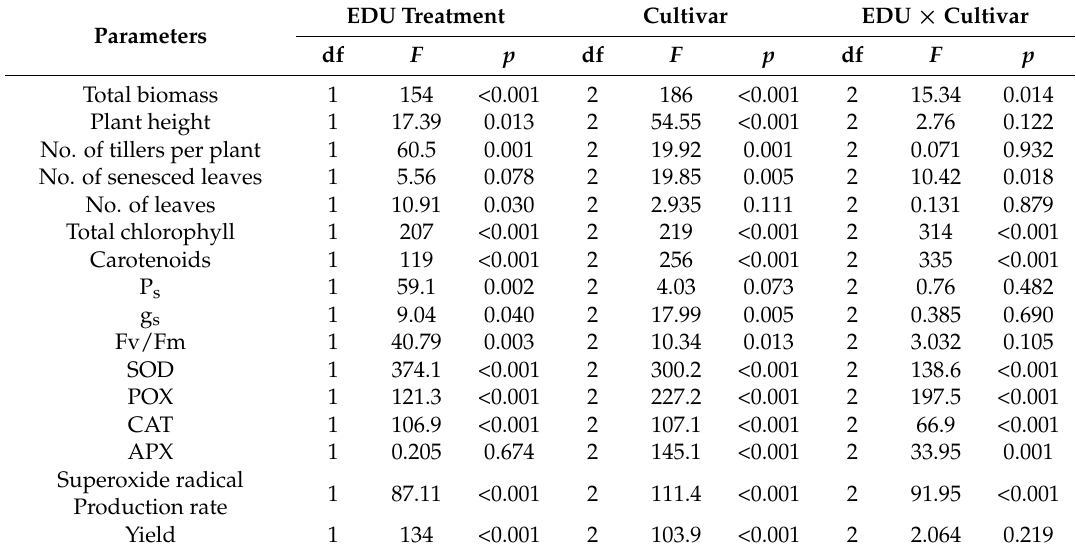
Table 1. Results of the split-plot ANOVA with their respective df (degrees of freedom), F ( F -value) and p (significance level) values for each of the studied parameters (n = 9). EDU treatment and cultivar are individual factors while EDU × Cultivar is the interactive factor. Here, P s : photosynthesis rate, g s : stomatal conductance and Fv/Fm: photosynthetic efficiency, APX: ascorbate peroxidase, POX: peroxidase, CAT: catalase and SOD: superoxide dismutase.